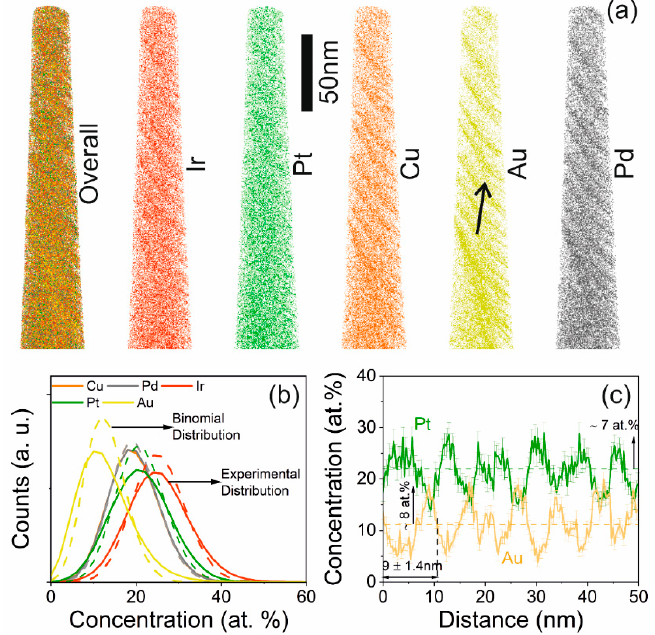
Figure 4. ( a ) A depiction of the overall elemental distribution as well as individual elemental distribution of Pt 22 Ir 23 Cu 18 Au 18 Pd 19 deposited at 520 ° C substrate temperature, via atom probe tomography. ( b ) Frequency distribution analysis of the respective constituting elements. ( c ) One-dimensional concentration profile along the direction highlighted in ( a ), depicting the chemical modulation of Au and Pt.